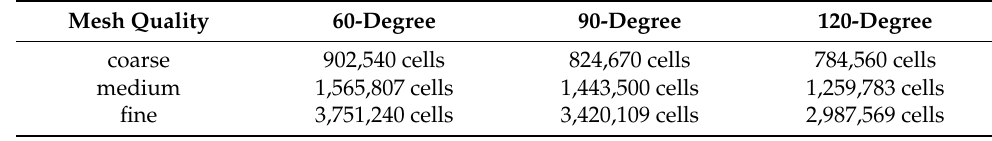
Table 2. The cell numbers of meshes for independent study.